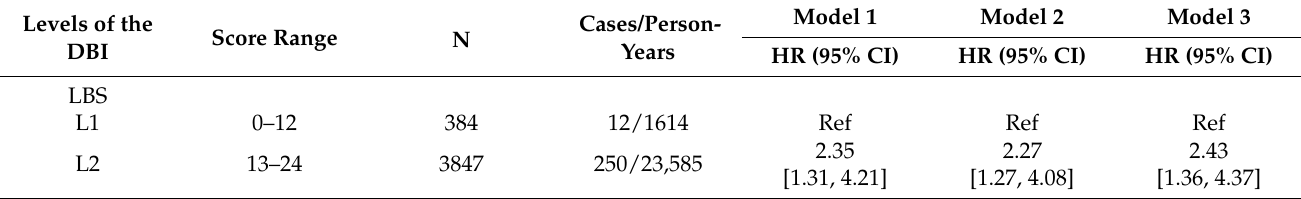
Table 3. The relative risk of developed diabetes, based on the levels of the LBS, HBS and DQD ( N =